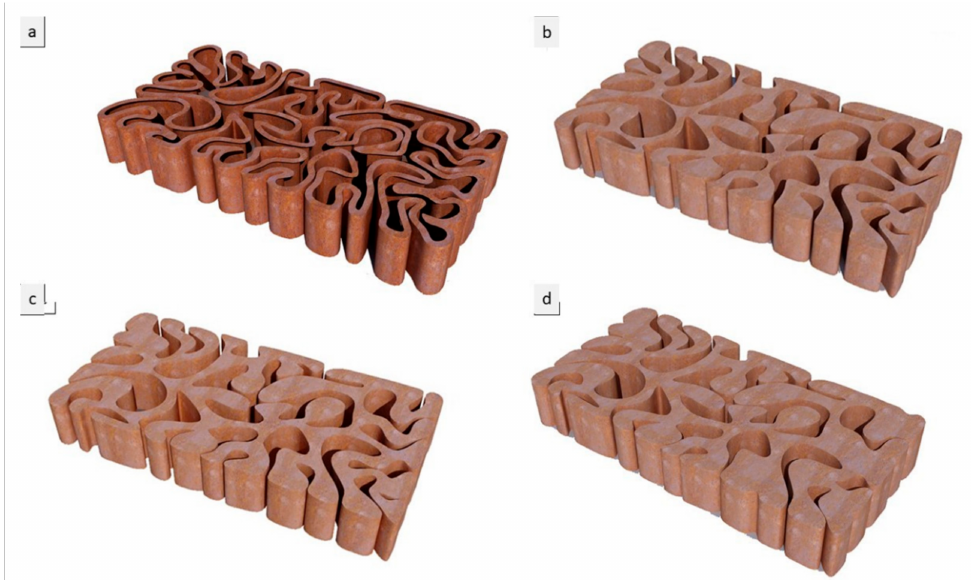
Figure 5. Alberto T. Est é vez (Yomna K. Abdallah, computational designer), Biodigital Barcelona Bricks (3D-printed clay), GENARQ/iBAG, UIC Barcelona. V1 design iteration of the Biodigital Barcelona Bricks showing the bricks’ varied material density from a linear model of 0.5 cm thickness to a bulk model ( a – d ), with the densities of the brick varying from 25% to 55% and 75%, to experiment structurally different densities of the 3D-printed bricks. Images by the author.